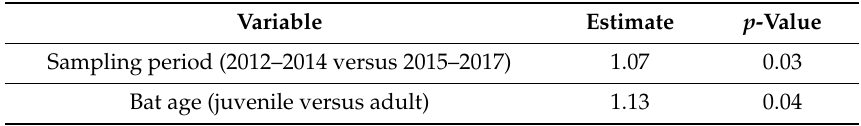
Table 3. Adjusted estimates and p -values for the multivariable binomial GLMM for rabies serological status for bats included in the serological analysis ( n =